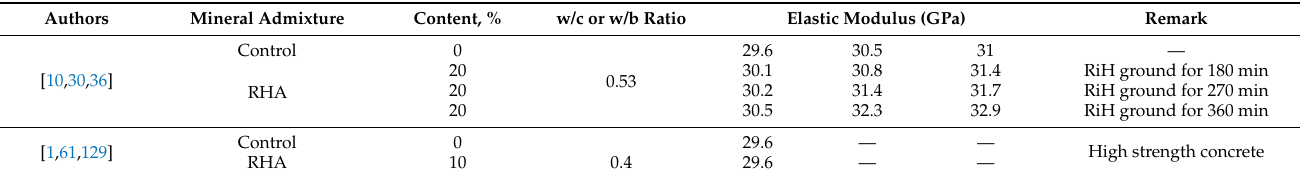
Table 7. Elastic modulus of the RHA